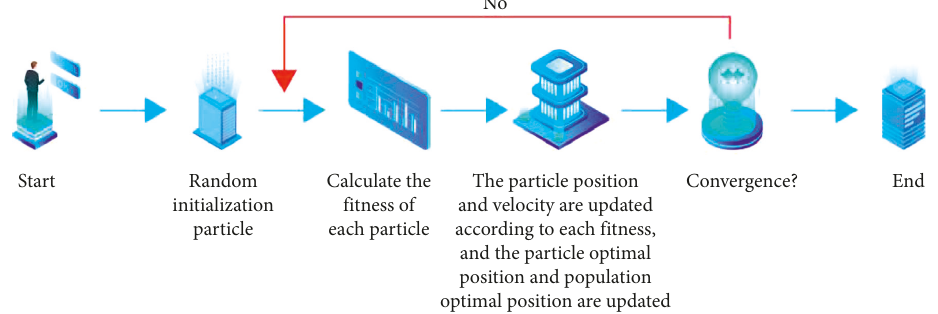
Figure 1: Based on particle swarm optimization